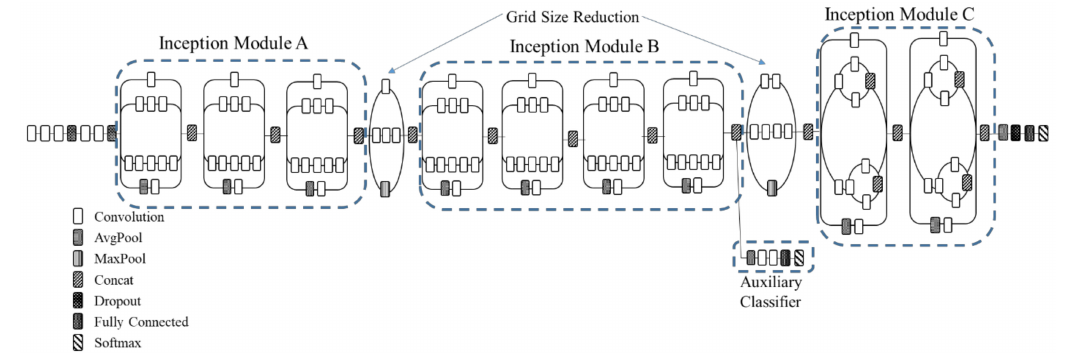
Figure 11. The complete architecture of Inception v3 [38].